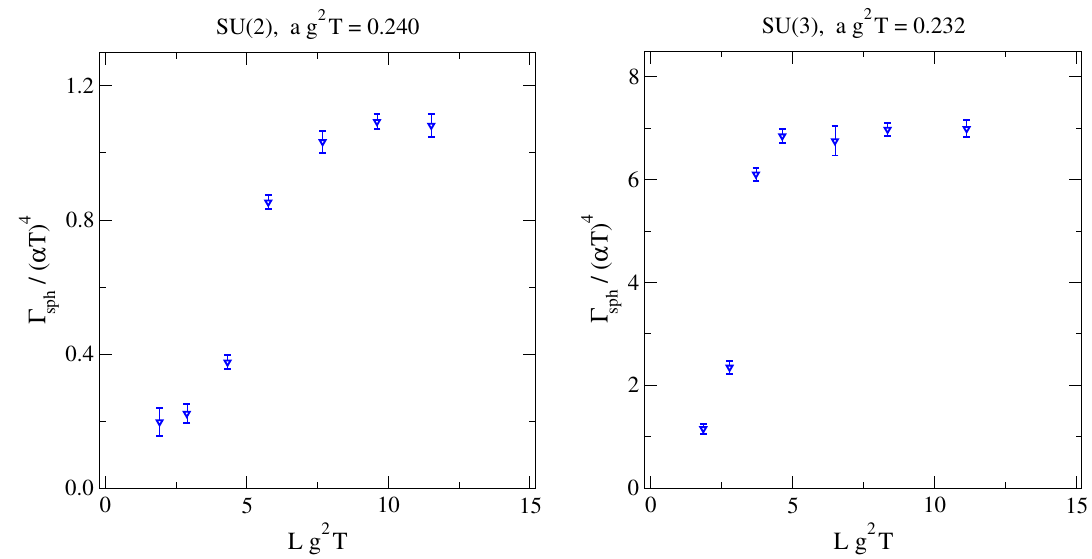
Figure 1 . Demonstration of the dependence of Γ the box. As expected theoretically [36], the volume dependence is exponentially small when L is large compared with the colour-magnetic screening scale ∼ 1 / ( g 2 T ) . For SU(3), smaller volumes suffice in these units, as thermal glueball masses increase in proportion to N